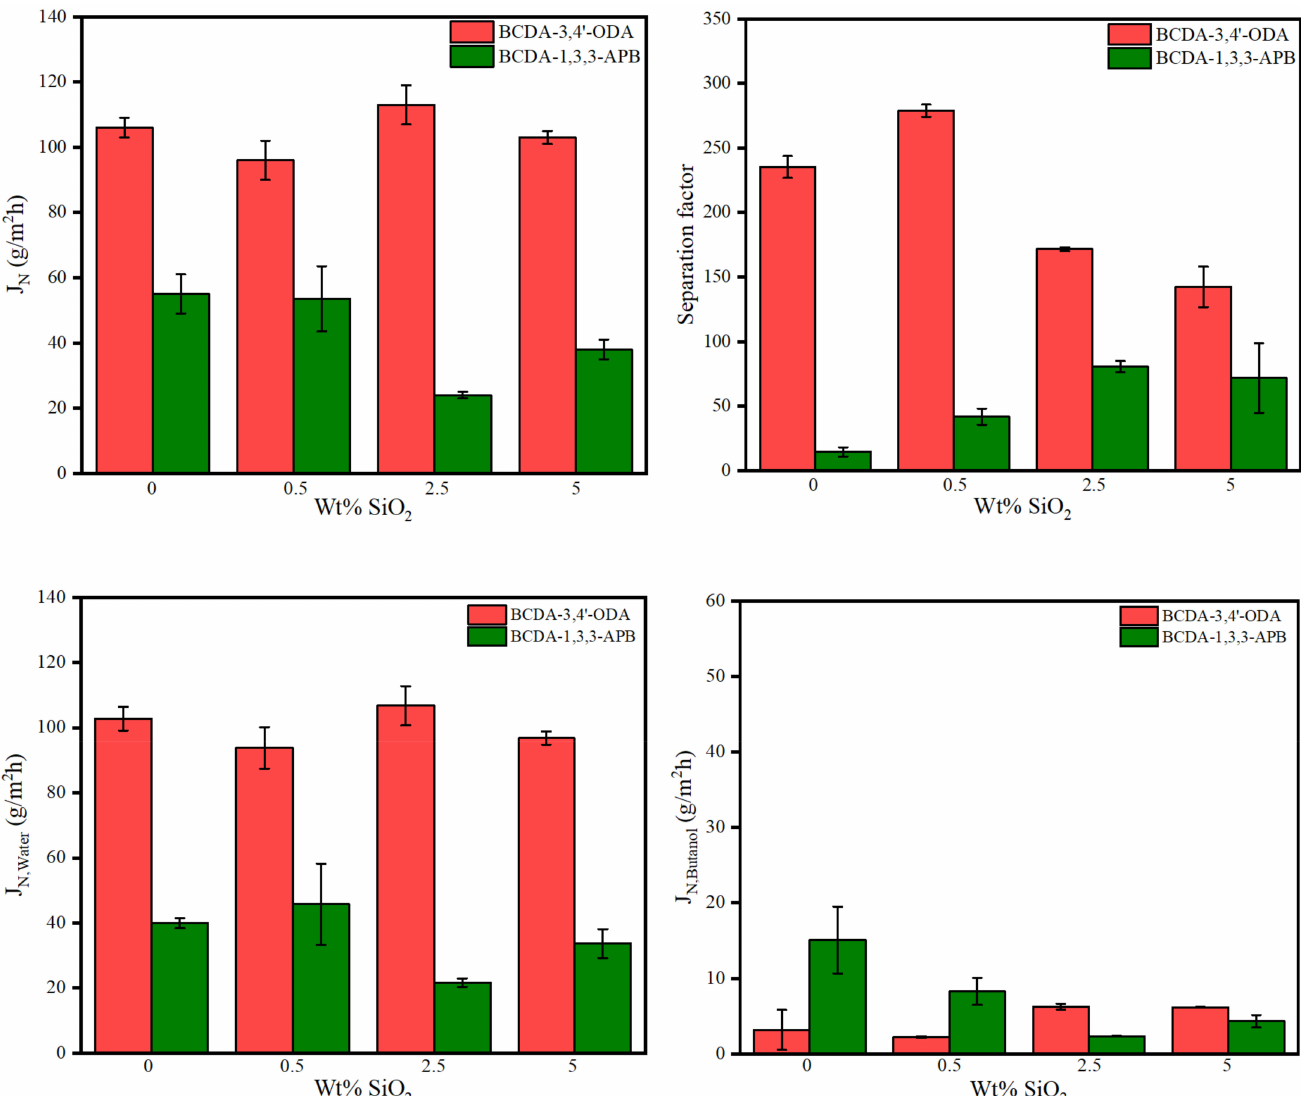
Figure 6. Pervaporation performance of pristine alicyclic PI membranes and their related PI/SiO 2 mixed matrix